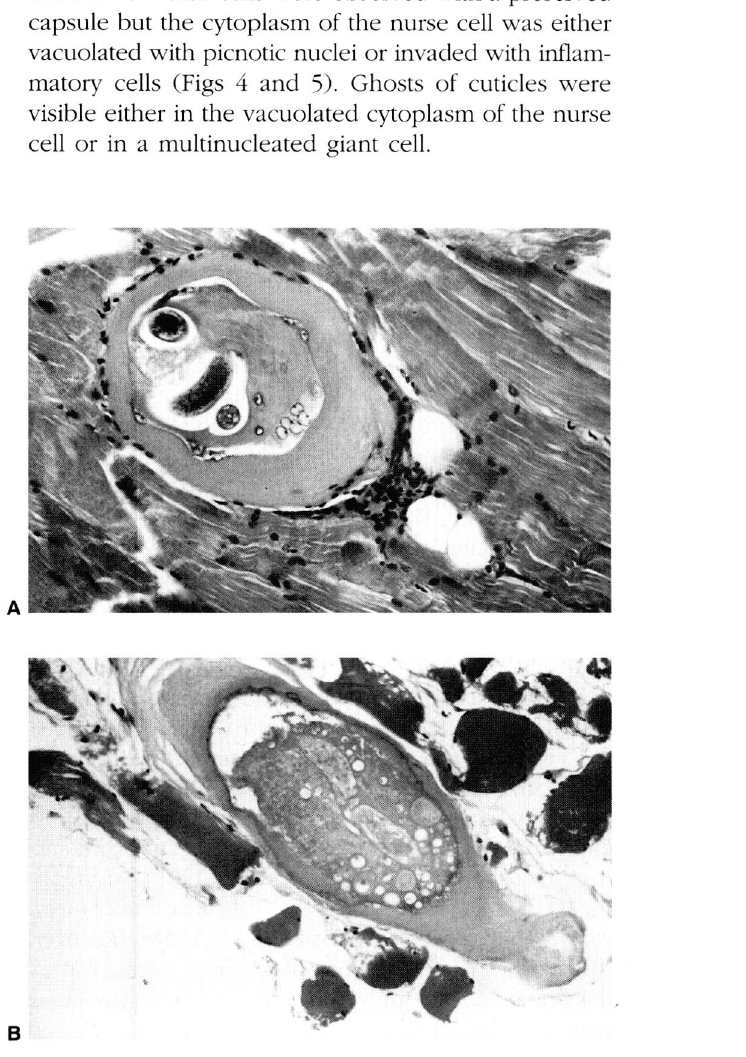
Fig. 3. - Transverse section of a muscle biopsy (case n° 3). A. Six years after the acute infection, presence of an encapsulated larva with a persisting inflammatory reaction around the very thick capsule. Original magnification x 400. B. Fourteen years after the acute infection, the nurse cell is dege nerated with a vacuolated cytoplasm and picnotic nuclei. The cap sule is still present and cuticular remnants of the worm can be seen. Original magnification X